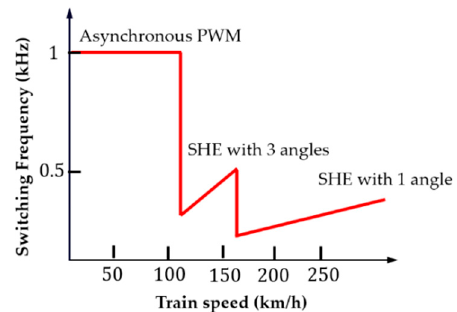
Figure 14. Modulation technique vs. train speed for a High-Speed Train (HST).